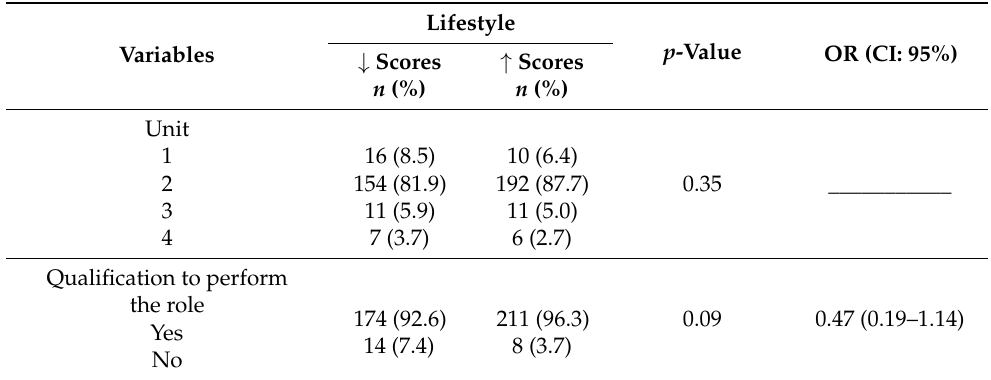
Table 2. Bivariate analysis of the association between lifestyle dichotomized into minor ( ↓ ) and major ( ↑ ) scores and work variables of health professionals in pediatric